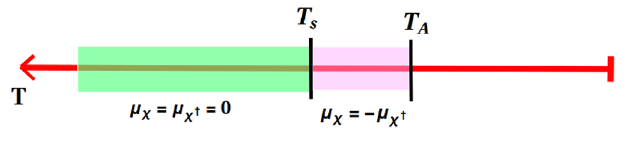
Figure 5 . One of the two possible hierarchies of the freeze-out temperature for the semi-annihilation ( T S ) and pair-annihilation ( T A ) processes, and the chemical potentials of the DM ( (cid:22) (cid:31) ) and anti-DM ( (cid:22) (cid:31) y ) states at di(cid:11)erent temperature intervals. sector is generically possible. Such an asymmetry is generated by the freeze-out of the semi-annihilation process once all the Sakharov conditions are satis(cid:12)ed. In this case,